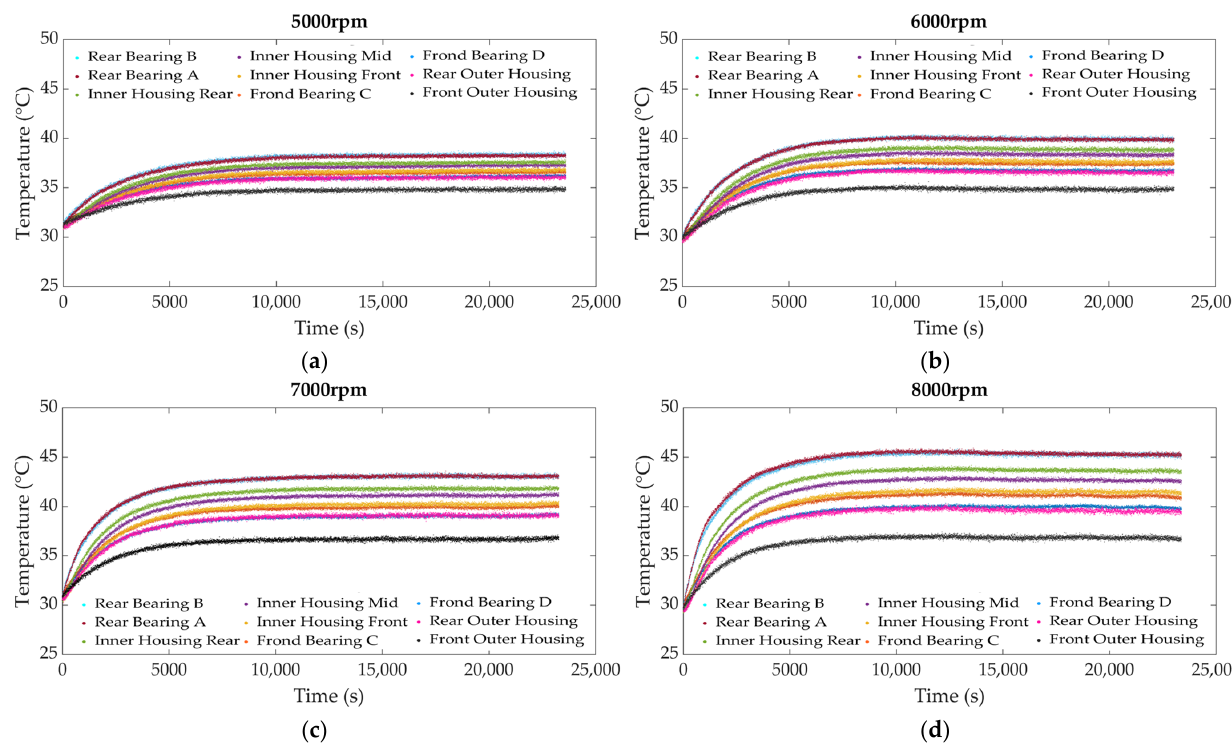
Figure 3. The demonstration of the feature temperatures measurement results under constant speed: ( a ) 5000 rpm; ( b ) 6000 rpm; ( c ) 7000 rpm; ( d ) 8000 rpm.